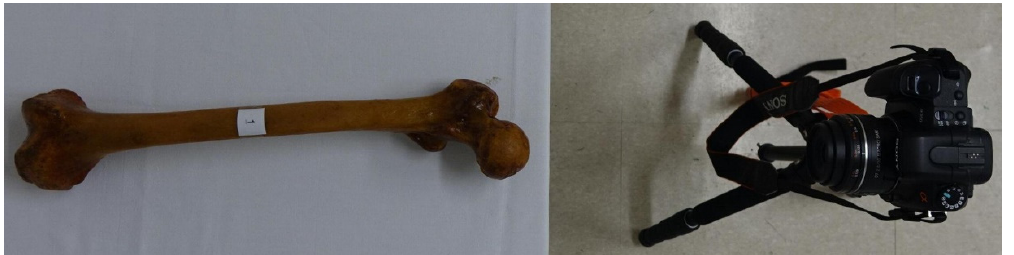
Figure 1. Method for measuring femoral anteversion using digital photography. A sample was placed on a table with the lens of the camera proximally placed on the same collinear axis through the femoral head and bisecting both femoral condyles to represent the mechanical axis of the femur.